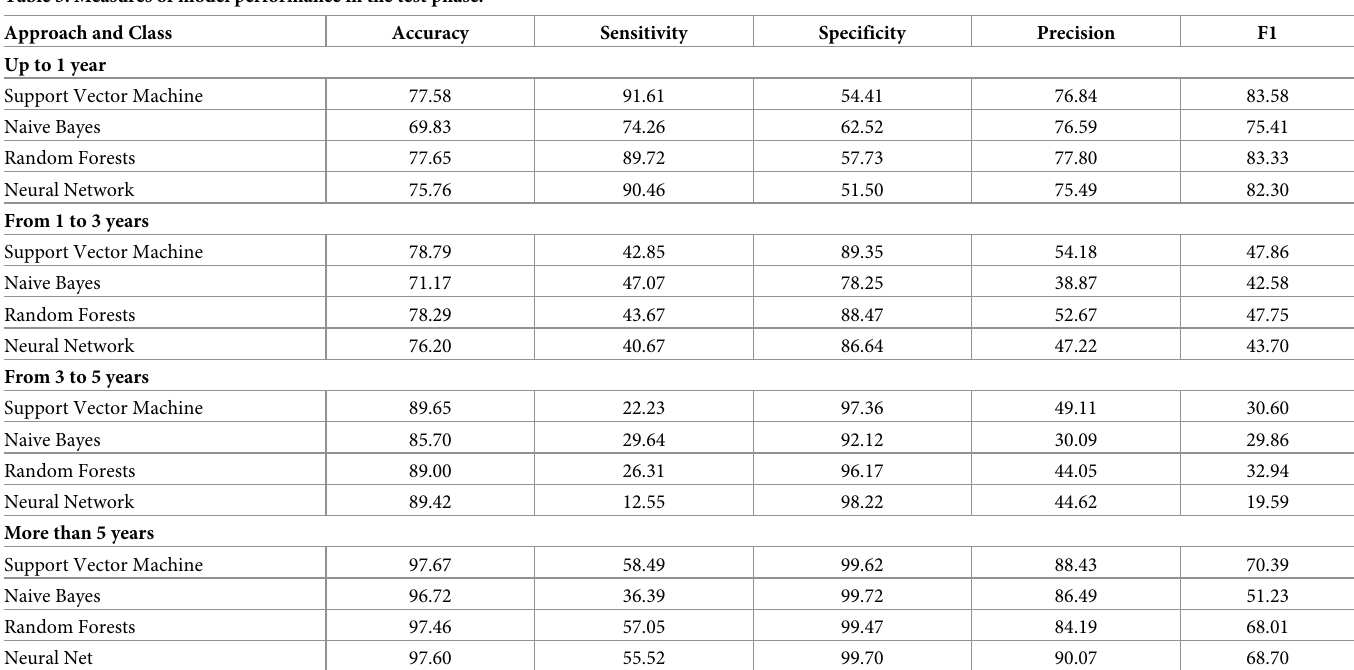
Table 3. Measures of model performance in the test phase.